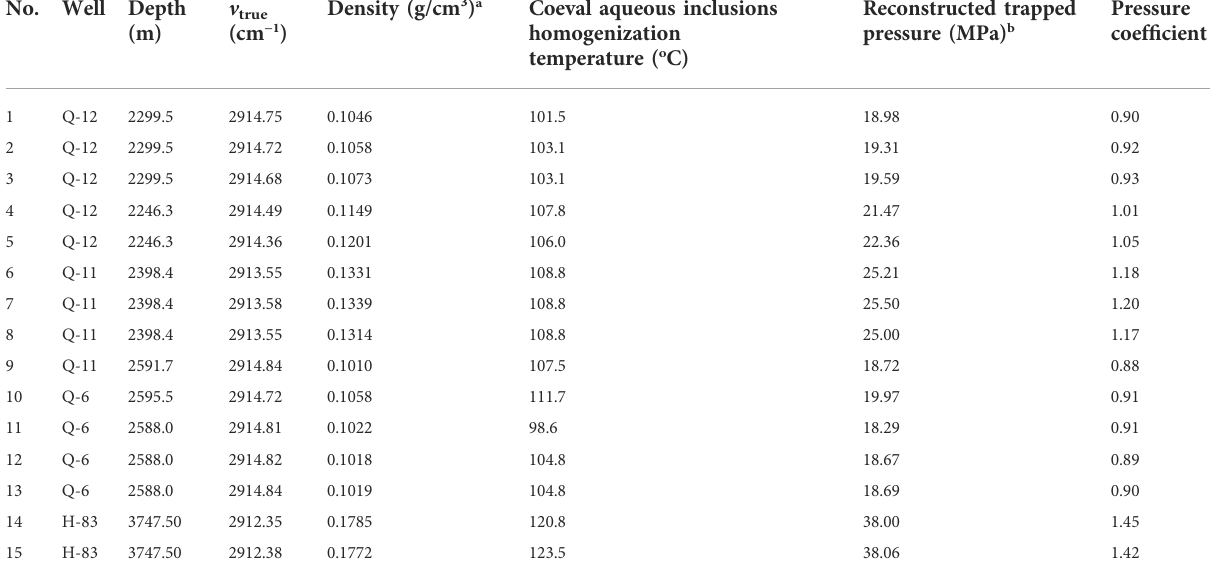
TABLE 1 Summary of Raman quantitative analysis of pure CH 4 inclusions.